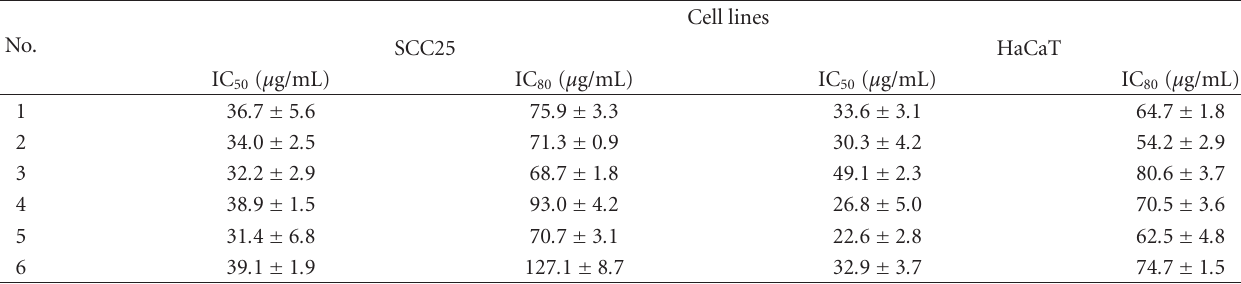
Table 2: Cell viability of the genus Sinularia extracts in SCC25 and HaCaT cells.